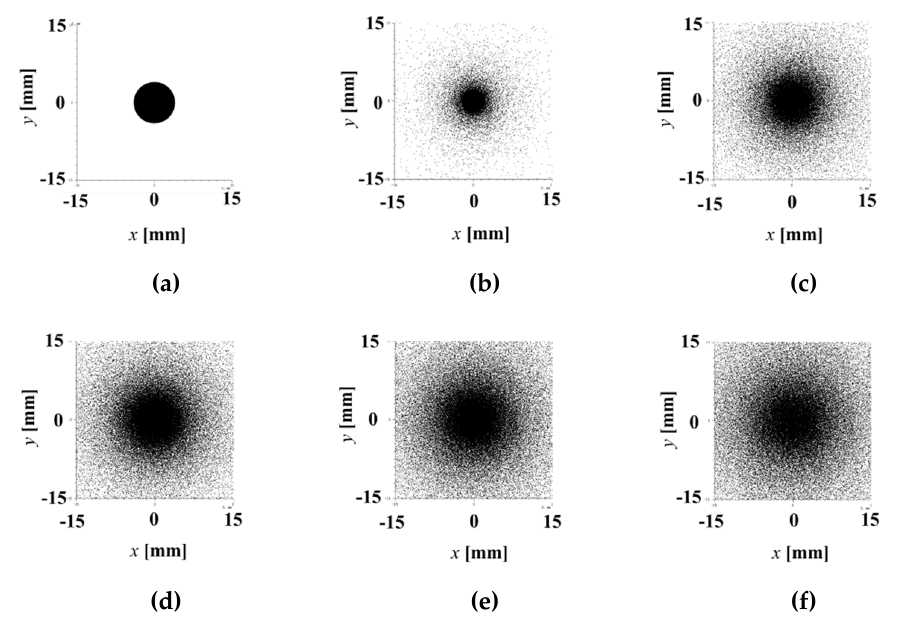
Figure 6. Simulated ray distribution of the KF-96-500cs homogenous spherical lens at the focal plane length f : f = ( a ) 15 mm, ( b ) 18 mm, ( c ) 24 mm, ( d ) 30 mm, ( e ) 36 mm, and ( f ) 42 mm.